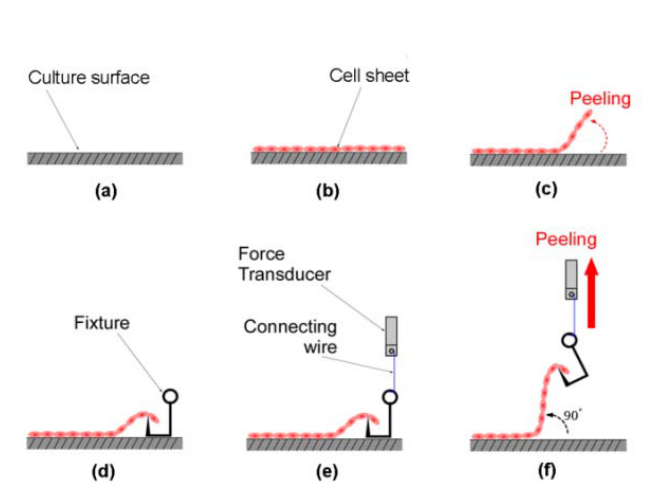
Fig. 5 Schematic diagram of the process for measuring adhesion force. ( dish bo ottom and formed a cell sheet. (b) After cultivation of the cell sheet was pee eled off the dish bottom by tweezers to make a peel leg. Then, (d) by the hooks of the multi hook type fixture, and (e) the multi hook ty transdu ucer by the connecting wire. Finally, (f) the angle between the cell manual lly to 90 ° , and the sheet was peeled from the dish bottom at a c force w was measured. DMS mask (Figs. 4 (c) and (d)), and the cell sheet wa DMS mask. After formation of the cell sheet, the PDM bottom. This process allowed formation of cell sheet HH cells, a kind of bovine endothelial cells (HE OURCES BANK, Japan), were cultured in Dulbe EM, High glucose, NACALAI TESQUE, Japan) con GIBCO, CA) and 1 % penicillin-streptomycin soluti rming confluence, cells were suspended in Dulbe BS, NACALAI TESQUE) and detached from their cu n solution (trypsin-EDTA, GIBCO) for 5 minutes. Th ulture treated polystyrene dish (3010-060, IWAKI, Jap d in it; other culturing conditions were 5 % CO ells/cm 2 .